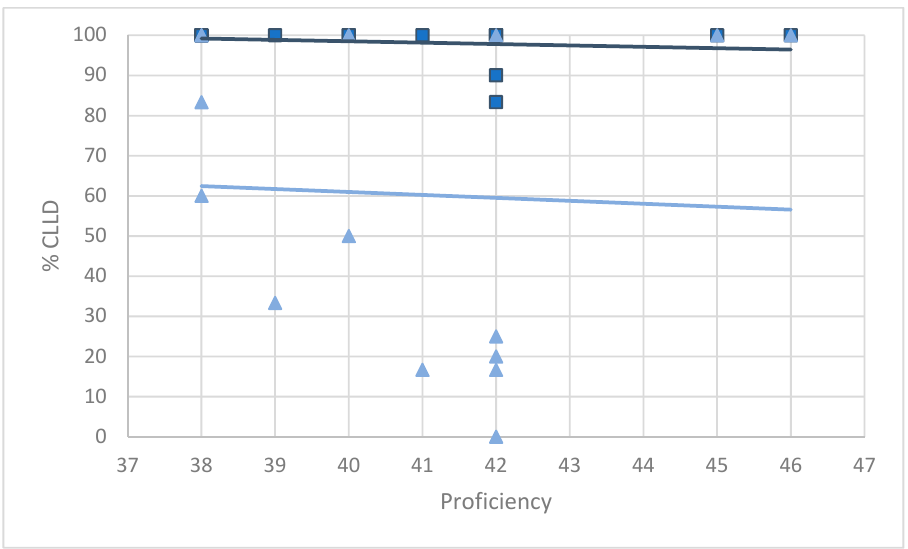
+ a] (dark blue) and in [ − a] (light blue) on the SPT, by proficiency Figure 5. Proportion of CLLD in [+a] (dark blue) and in [ − a] (light blue) on the SPT, by proficiency score. Figure 5. Proportion of CLLD in [